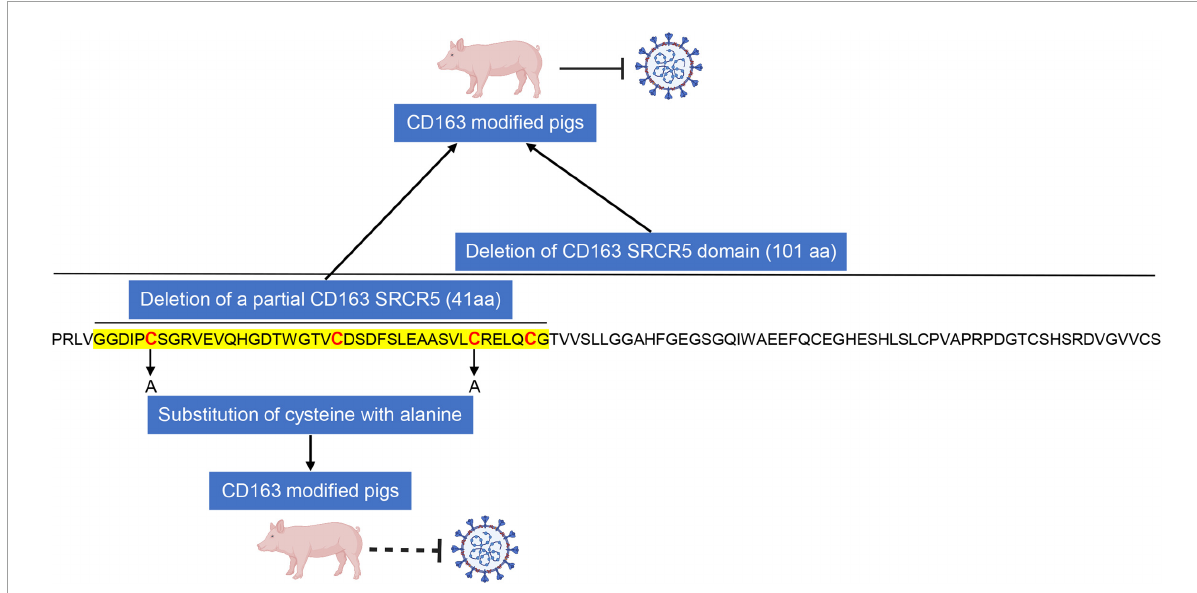
FIGURE2 CD163 modified pigs may not be susceptible to infection with PRRSV by performing cysteine to alanine replacements in SRCR5 domain. Deletion of entire or partial CD163 SRCR5 domain confers resistance of pigs to PRRSV infection. Furthermore, substitution of cysteine at positions 10 and 39 with alanine in SRCR5 region of CD163 can render cells resistant to infection by PRRSV, indicating that cysteine residues in SRCR5 domain of CD163 play critical roles in mediating virus uncoating and replacement of cysteine with alanine in SRCR5 would be enough to confer resistance of CD163 modified pigs to PRRSV. The location of deletion of 41 amino acids in our previous study (Guo et al., 2019) are indicated in sequence of SRCR5 region and the cysteine location are labeled in red.